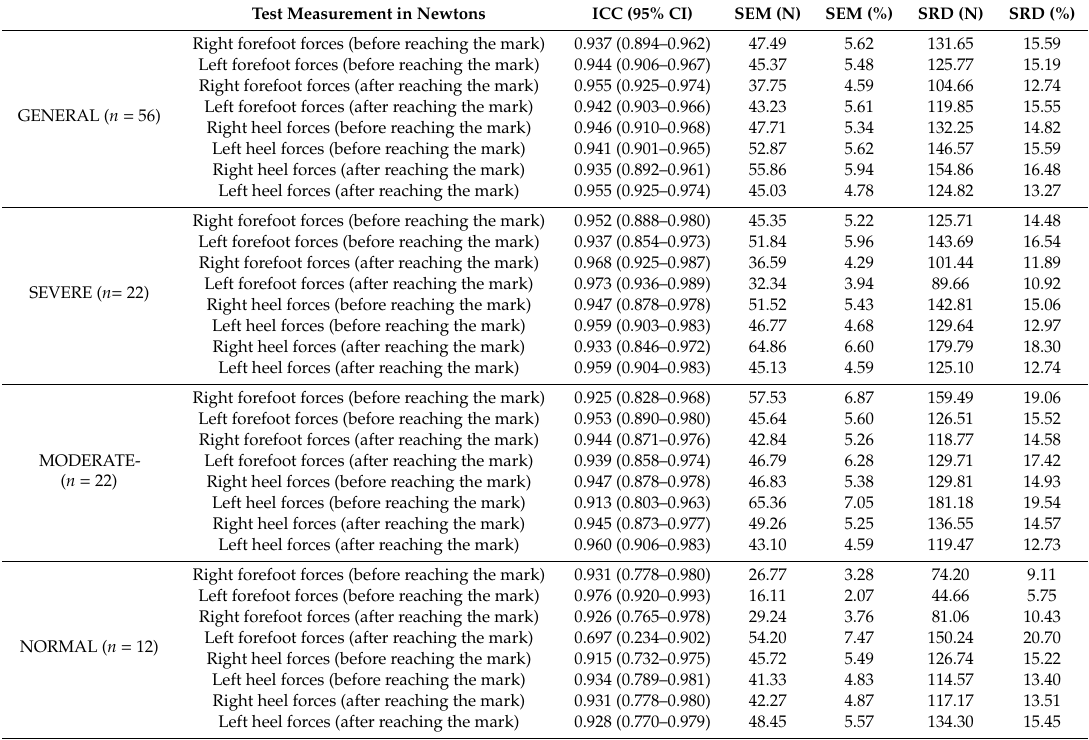
Table 5. Test-retest analyses on the peak forces from the heel and the forefoot forces in the entire sample and in participants with (a) severe neuropathy, (b) moderate neuropathy and (c) normal perception. Test Measurement in